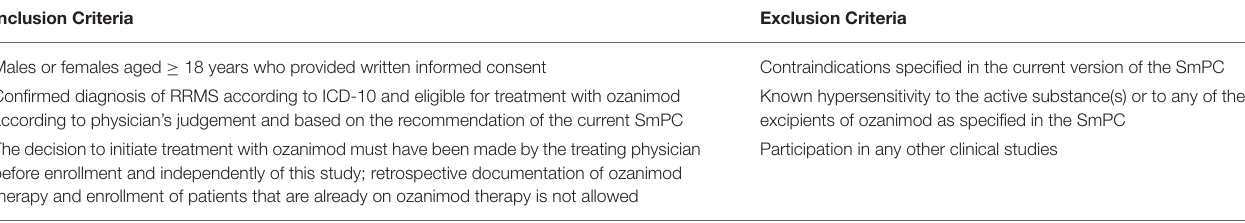
TABLE 1 | Eligibility criteria. Inclusion Criteria Exclusion